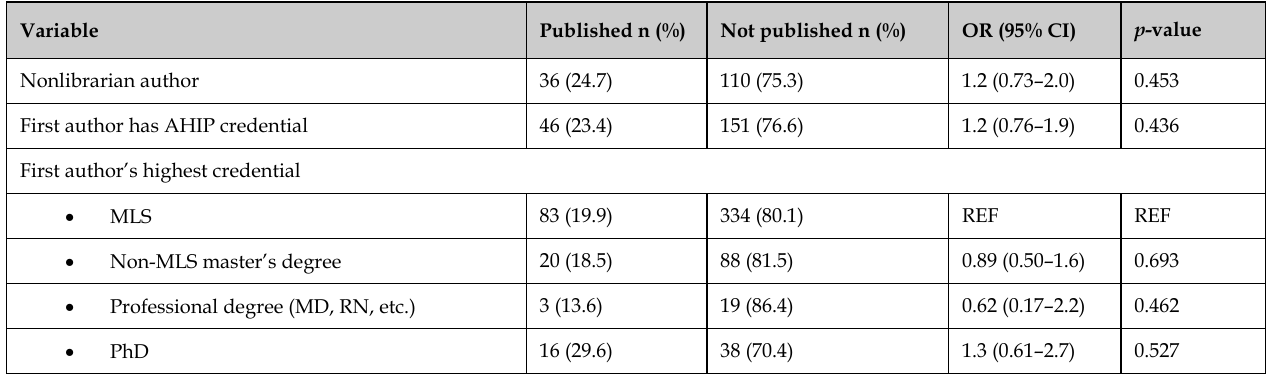
Table 3 Potential variables associated with publication: authors